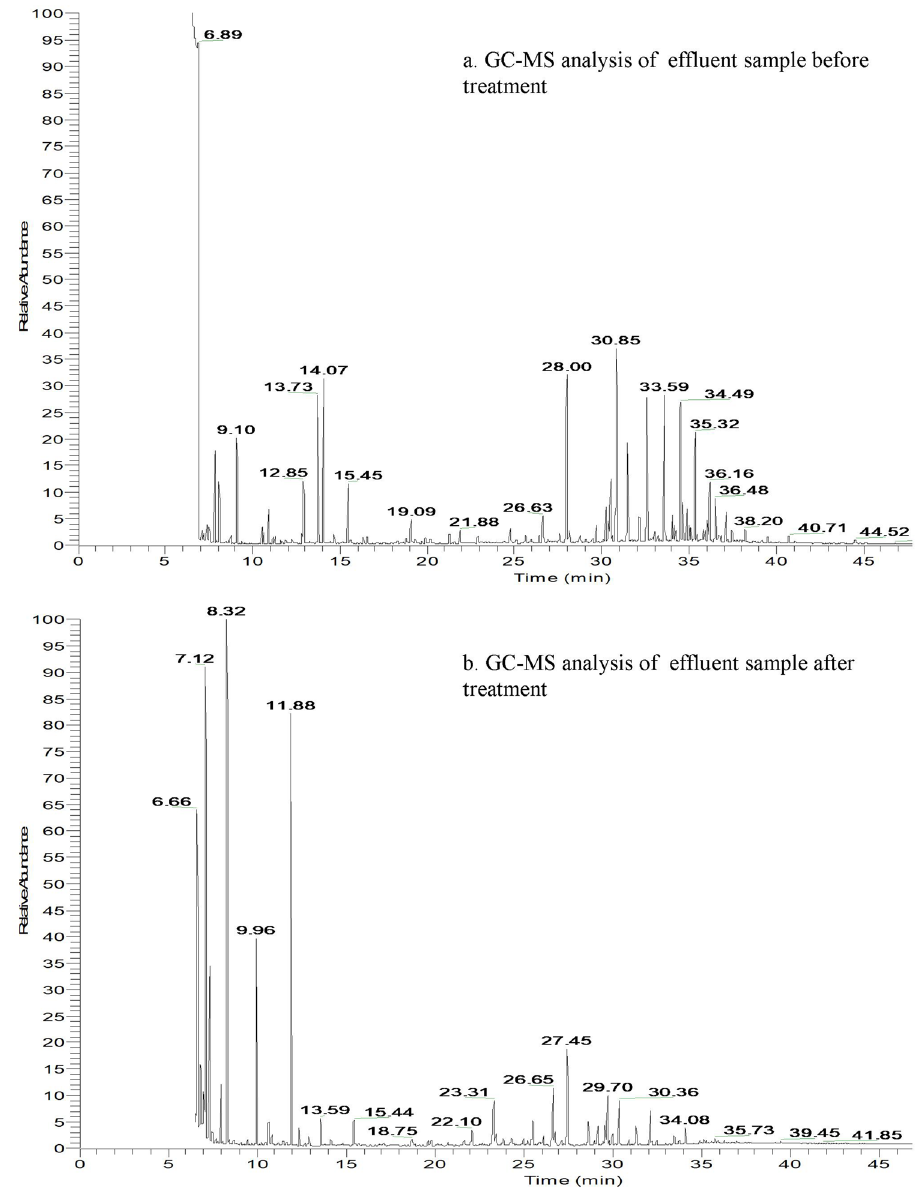
Figure 4. GC–MS analysis of effluent ( a ) before treatment and ( b ) after bacterial